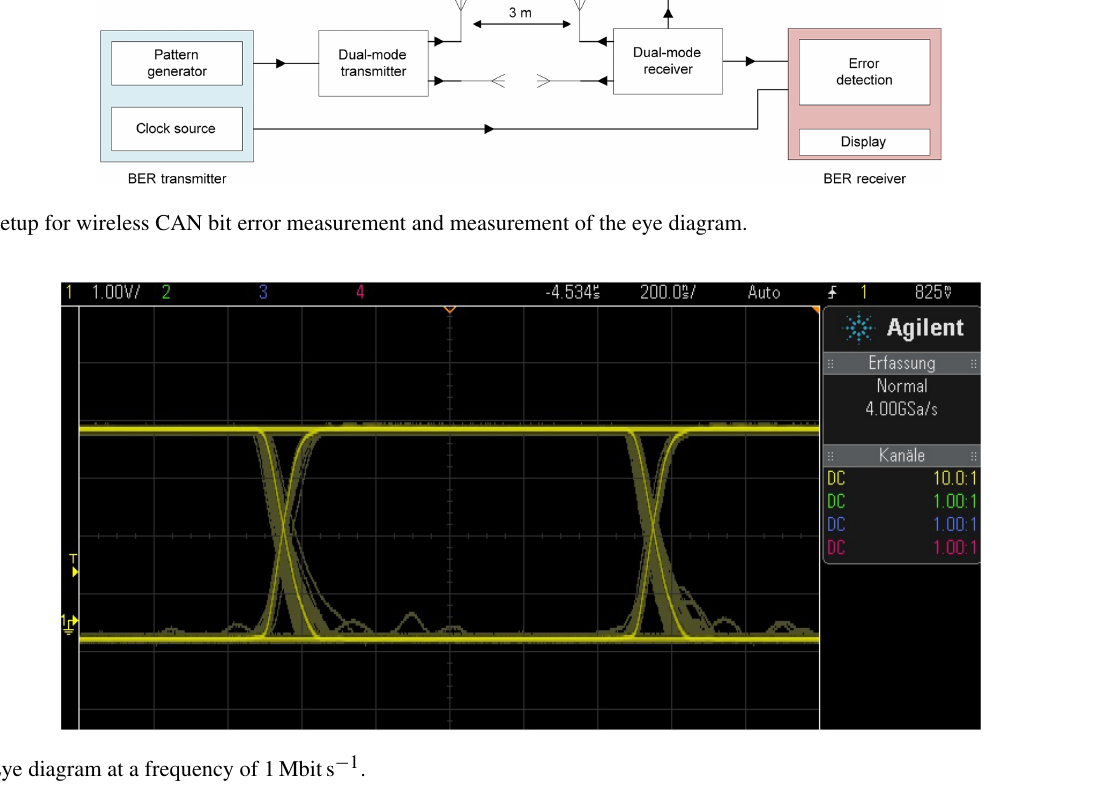
Figure 9. Eye diagram at a frequency of 1Mbits − 1